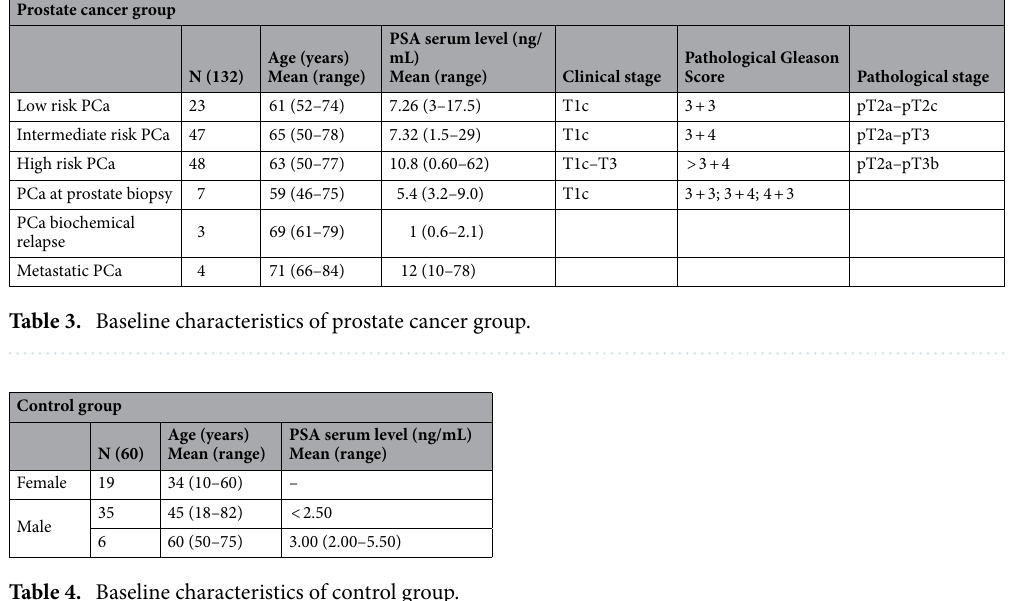
Table 4. Baseline characteristics of control group.